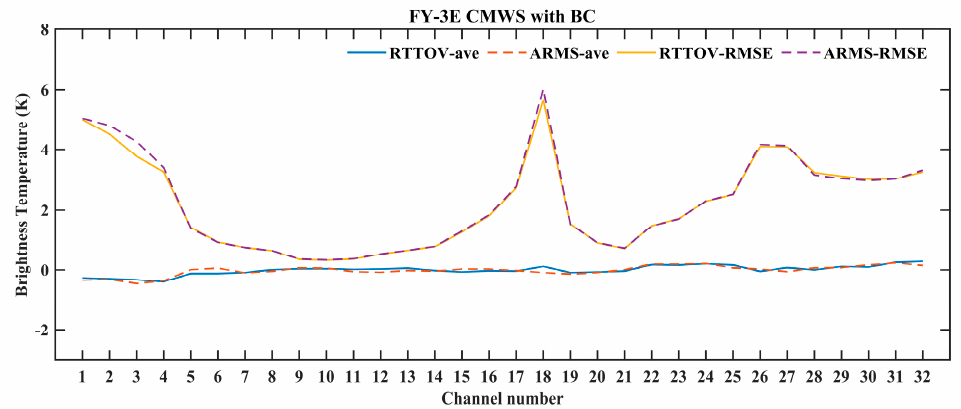
Figure 11. The same as Figure 9, but with bias correction.